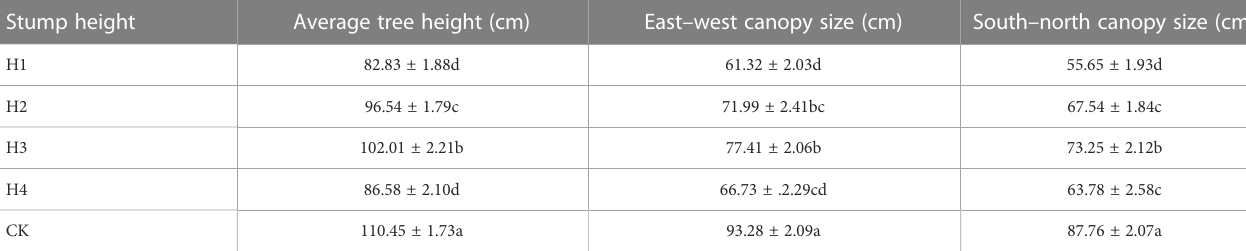
TABLE 1 Growth of H. rhamnoides at different stump heights. Stump